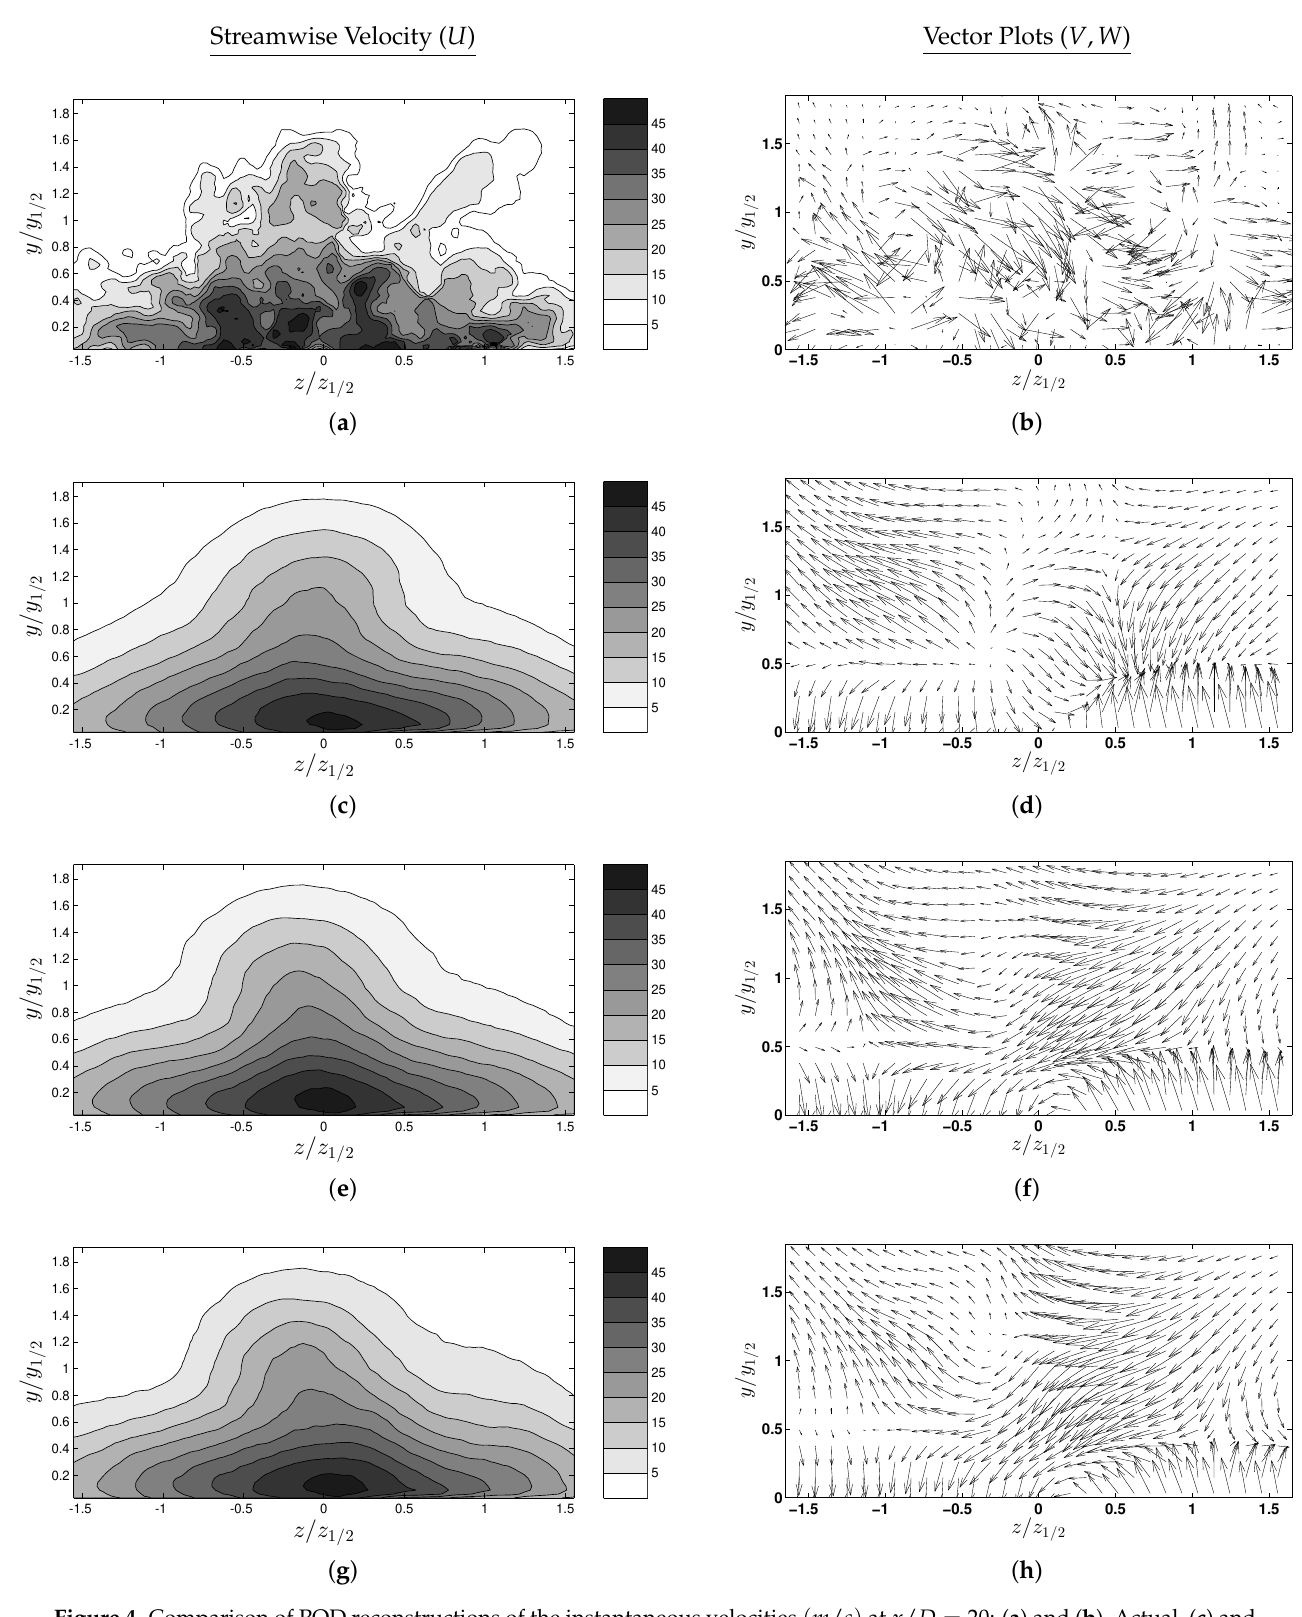
Figure 4. Comparison of POD reconstructions of the instantaneous velocities ( m / s ) at x / D = 20: ( a ) and ( b ) Actual, ( c ) and ( d ) using the first five POD modes, ( e ) and ( f ) using the first 10 POD modes, and ( g ) and ( h ) using the first 15 POD